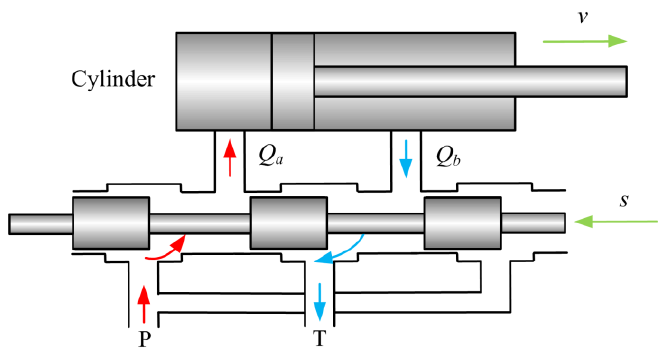
Figure 1. Principle of a spool valve controls a cylinder.